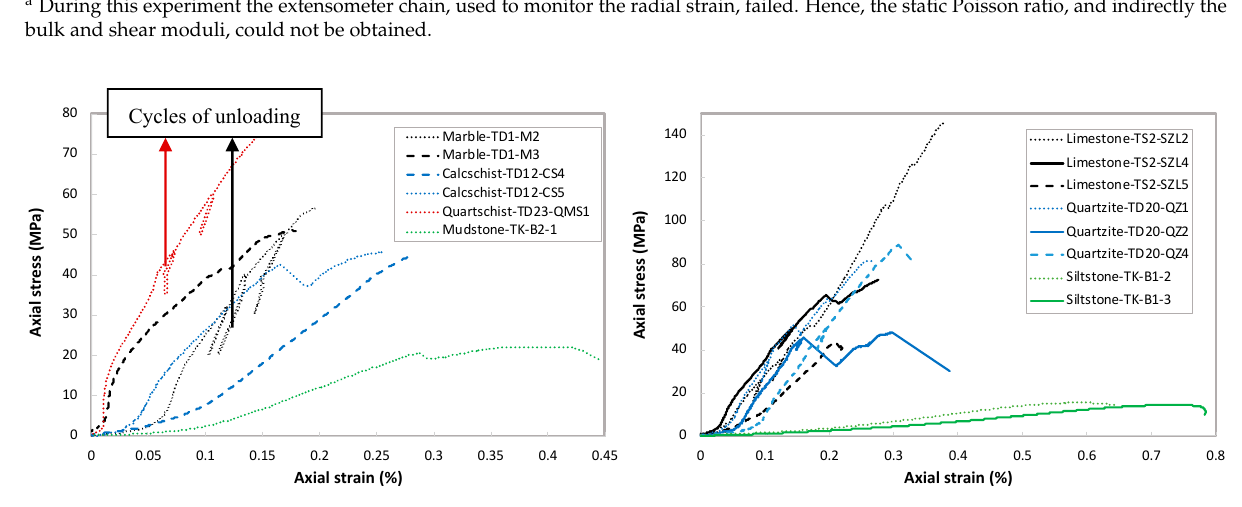
Table 8. Static elastic parameters obtained from the UCS experiments.